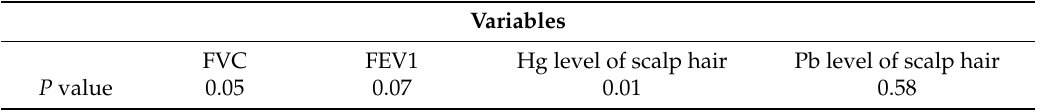
Table 4. Comparison of the variables between miners and non-miners.